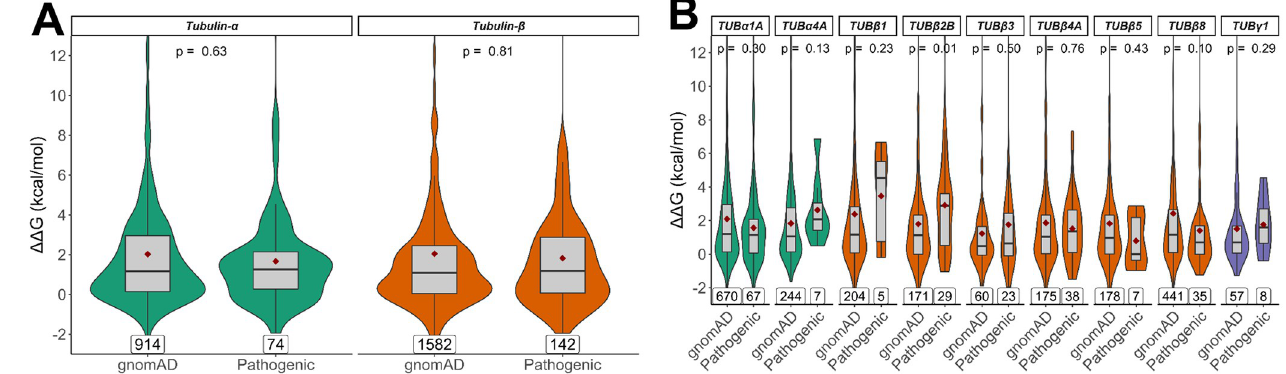
Fig 3. Comparison of predicted changes in protein stability between pathogenic and putatively benign tubulin mutaitons. ΔΔ G values representing the predicted change in free energy of folding were calculated with FoldX considering the structure of the monomeric subunit only. Scores are shown for tubulin- α and - β families globally (A) and in isotypes with at least five identified pathogenic mutations (B) . Maroon diamonds indicate the mean ΔΔ G values, and mutation totals for each group are also shown at the bottom. The p-values displayed were obtained via unpaired Wilcoxon tests.